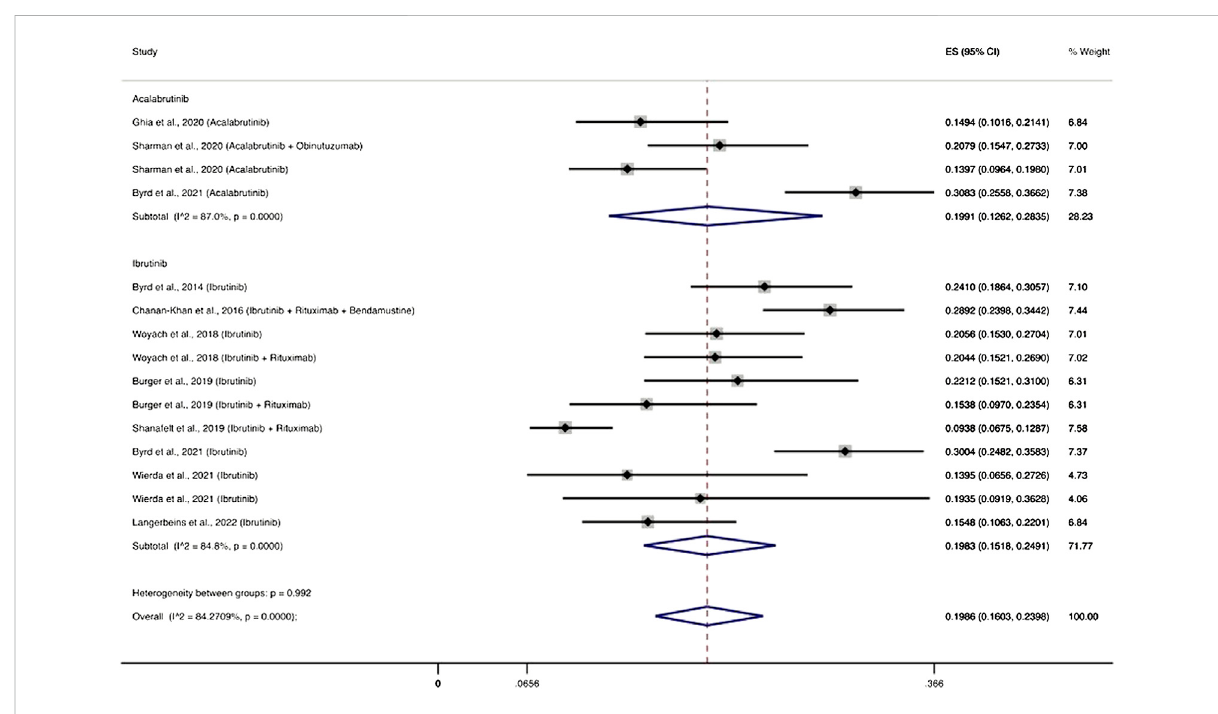
FIGURE 3 BTKicompoundsandthecumulativeincidenceofsevereinfections.Individualandcombinedestimatesoftheincidenceofsevereinfectionsfor patients treated with acalabrutinib and ibrutinib with 95% con fi dence intervals. ES: Effect Size (Cumulative incidence).